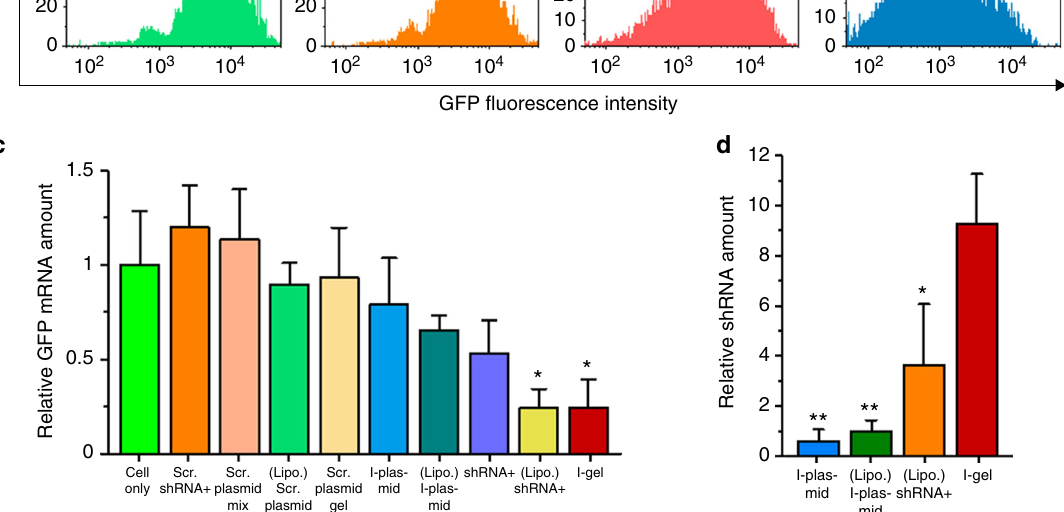
signi fi cance of the GFP mRNA inhibition ef fi ciency difference between the controls and I-gel, we have performed one-way ANOVA and Holm – Bonferroni post test among the multiple groups (Supplementary Table 3). When the cell-only condition